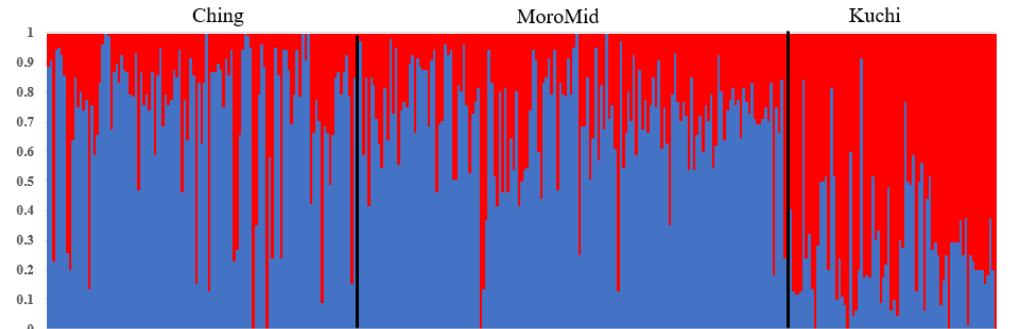
Figure 1. The admixture plot showing mixed ancestry among individuals for the three populations. ecotypes; Ching, Kuchi and MoroMid.